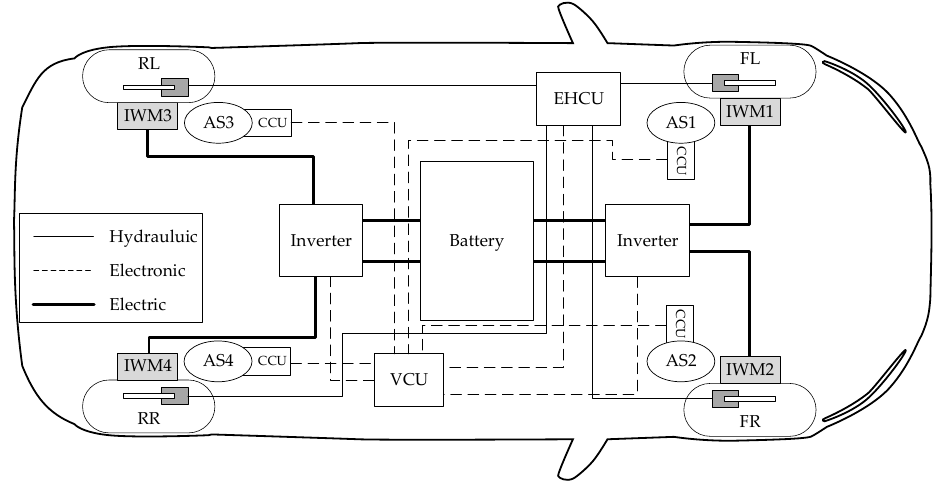
Figure 2. Configuration of the full electric vehicle under analysis. IWM—In-wheel motor; AS—Active suspension; CCU—Corner control unit; EHCU—Electrohydraulic control unit; VCU—Vehicle control